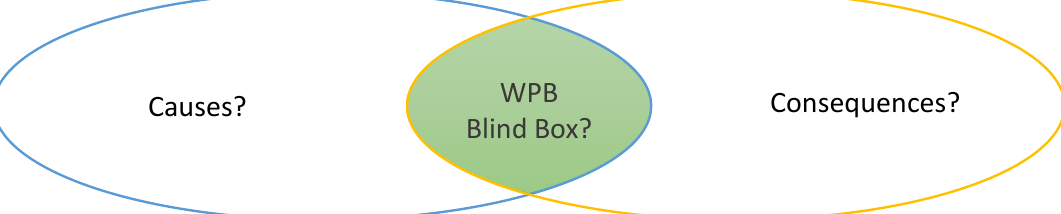
Figure 1. The “blind box” (adapted from Faulx (2007))